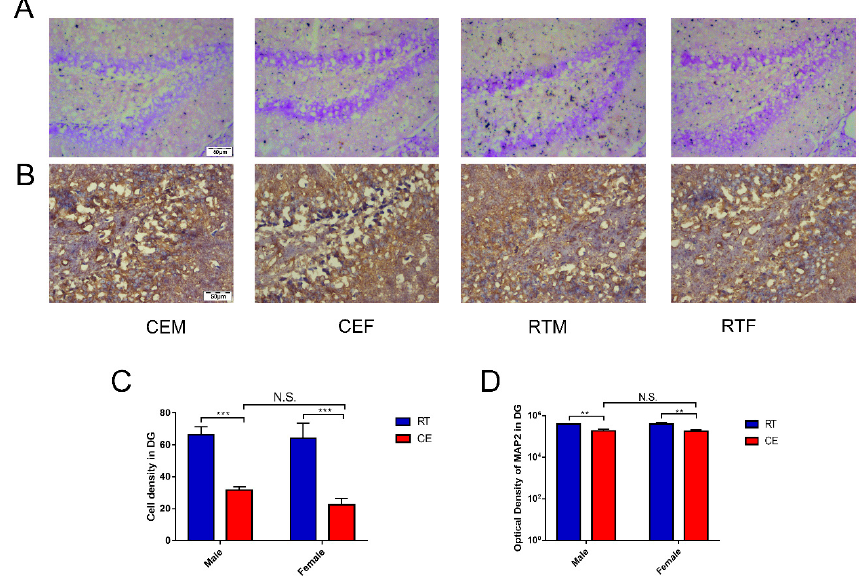
Figure 6. Expression of the neuronal dendrite marker microtubule-associated protein (MAP)2 in the dentate gyrus (DG) of cold-stressed mice. ( A ) MAP2 expression in the DG was detected by immunohistochemistry. Scale bar = 50 µ m. ( B ) Representative Nissl staining of the DG region. Scale bar = 50 µ m. ( C ) Quantification of the MAP2 expression level by densitometry. Differences between room temperature male (RTM) and cold exposure male (CEM), room temperature female (RTF) and cold exposure female (CEF), and CEM and CEF groups were evaluated by two-way analysis of variance. Results are expressed as the mean ± SD ( n = 6) of four independent experiments. N.S.: not significant; ** p < 0.01. ( D ) Quantification of Nissl-positive cells in the DG. Differences between RTM and CEM, RTF and CEF, and CEM and CEF groups were evaluated by two-way analysis of variance. Results are expressed as the mean ± SD ( n = 6) of four independent experiments. N.S.: not significant; *** p < 0.001.